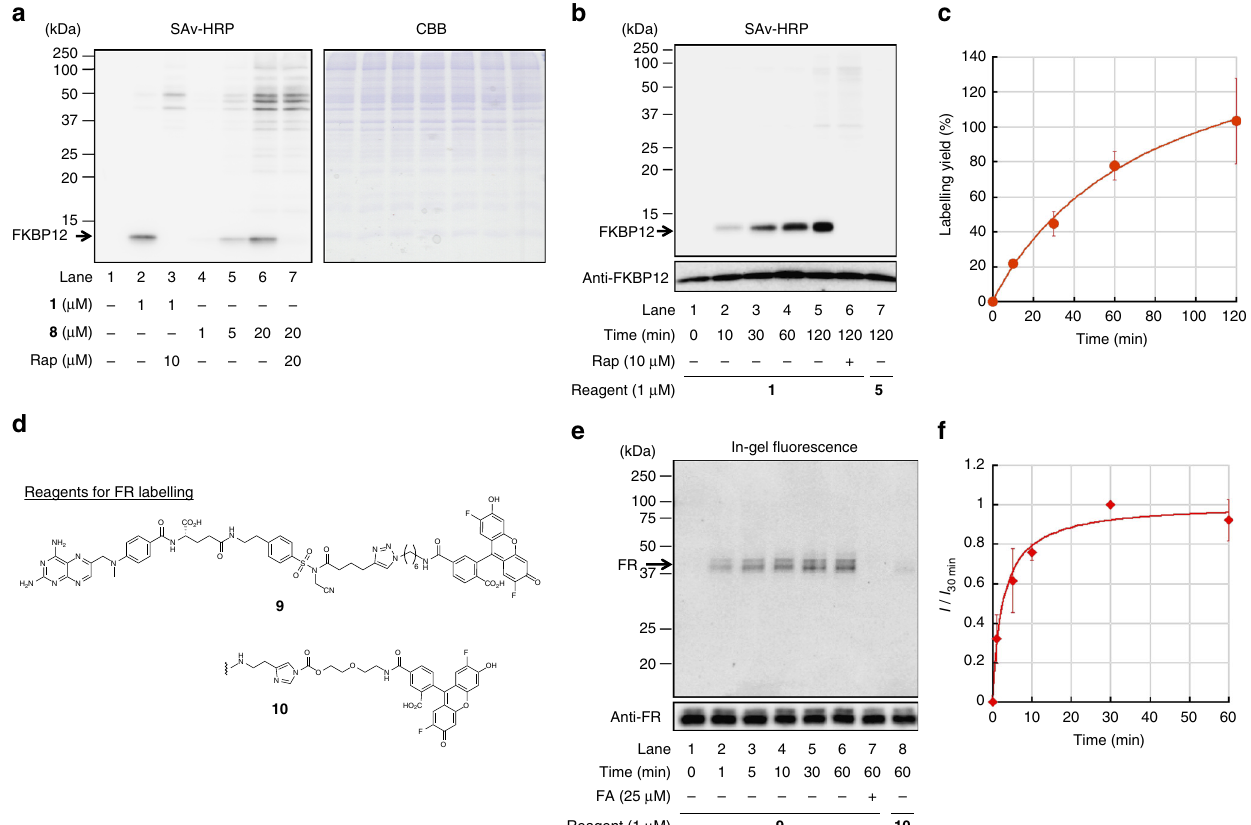
Fig. 4 Target-selective protein labelling with LDNASA chemistry. a Western blotting analysis of FKBP12 labelling in cell lysates. HeLa cell lysate was mixed with recombinant FKBP12 (1 µ M) and incubated with reagent in 50 mM HEPES buffer, pH 7.2, 37 °C, 1 h. SAv-HRP, streptavidin – horseradish peroxidase conjugate; CBB, Coomassie brilliant blue staining. The high background (smear) signals of lane 6 and 7 may suggest unspeci fi c labelling due to a high concentration of reagent (20 µ M), whereas such background signals were less in lanes 1 – 5 (1 – 5 µ M of reagent). b Western blotting analysis of endogenous FKBP12 labelling in live C2C12 cells. The cells were treated with 1 or 5 (1 µ M) for 0 – 120 min at 37 °C in medium. c Time course plot of the endogenous FKBP12 labelling with 1 . d Molecular structures of LDNASA 9 and LDAI 10 for FR labelling. e In-gel fl uorescence and western blotting analysis of endogenous FR labelling in KB cells. The cells were treated with 9 or 10 (1 µ M) for 0 – 60 min at 37 °C in medium. FA, Folic acid (competitive inhibitor). f Time pro fi le of the endogenous FR labelling with 9 . I and I 30min are band intensities of Oregon Green-labelled FR at the indicated time point and at 30 min, respectively. Error bars represent s.d., n =